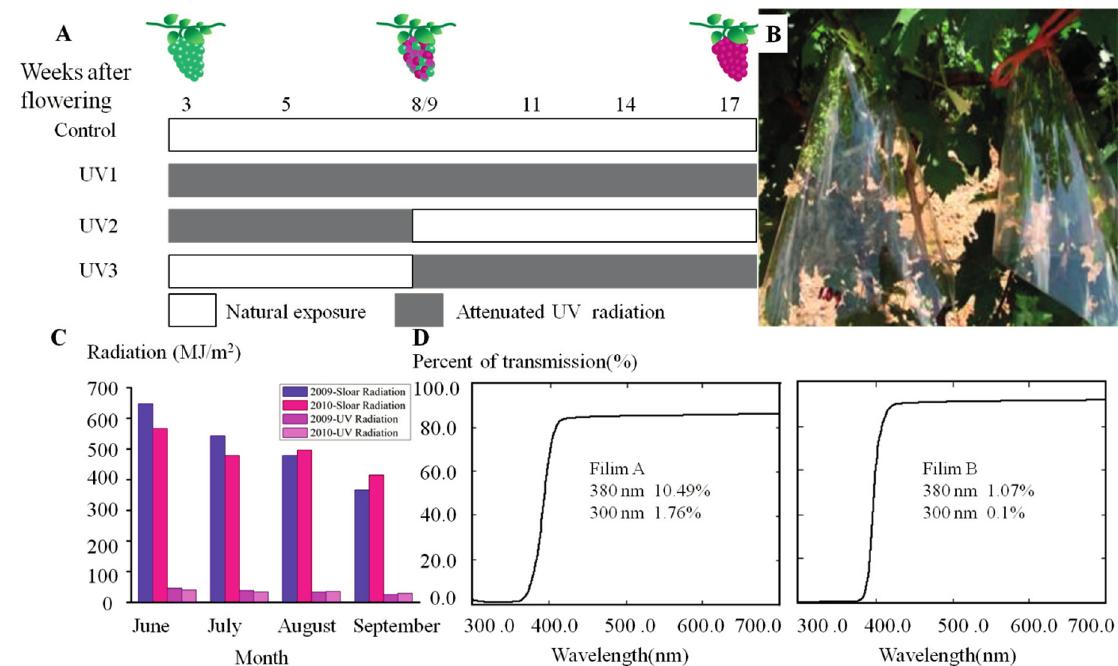
Figure 7. ( A ) Experimental design of the attenuated UV radiation treatments in the